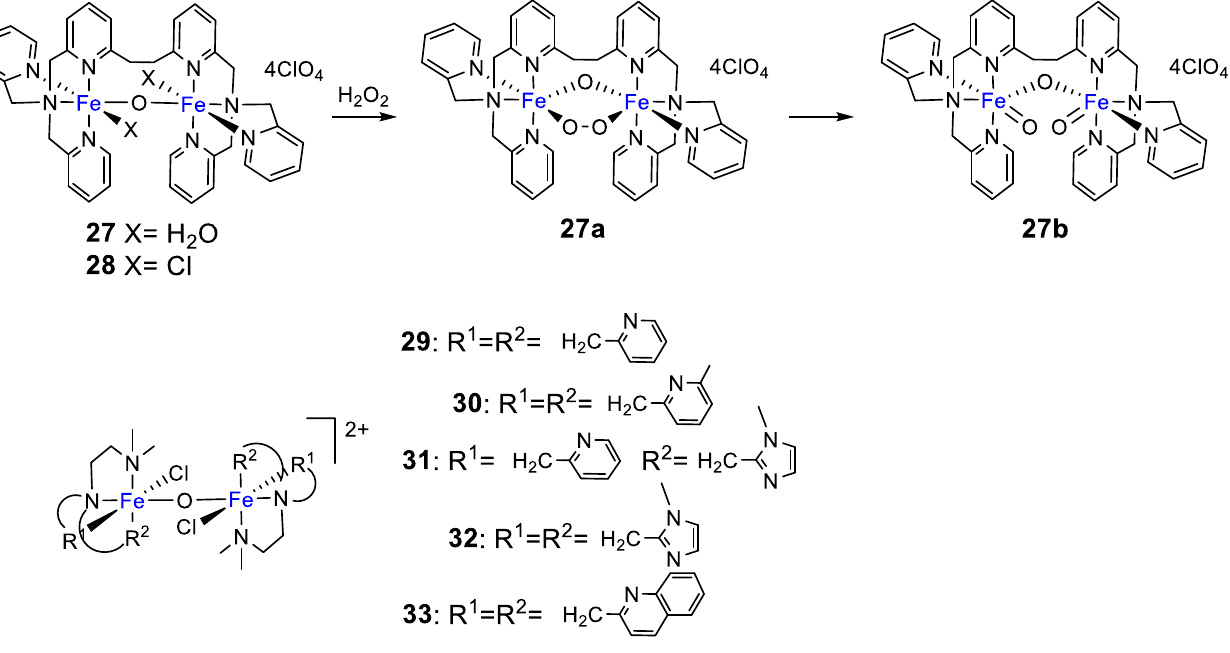
Figure 6. High reactive μ -oxodioxodiiron(IV) active species and μ -oxodiaquadiiron(III) complexes.